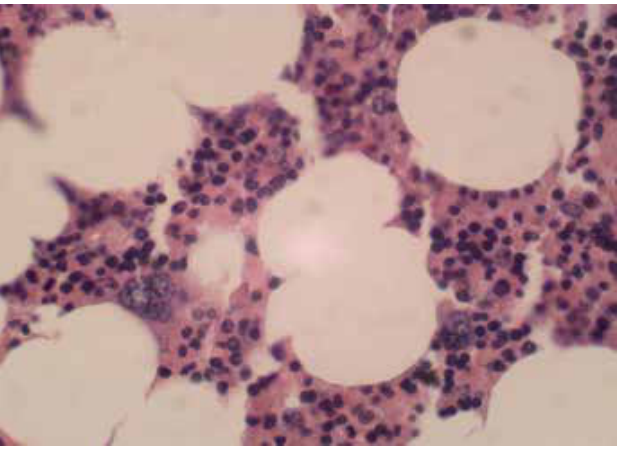
figuRE 5 − Neoplasm formed by adipocytes and elements of the three hematopoietic lineages (erythroid, myeloid and megakaryocytic). On the left side of the image, a mature megakaryocyte stands out (40× magnification)